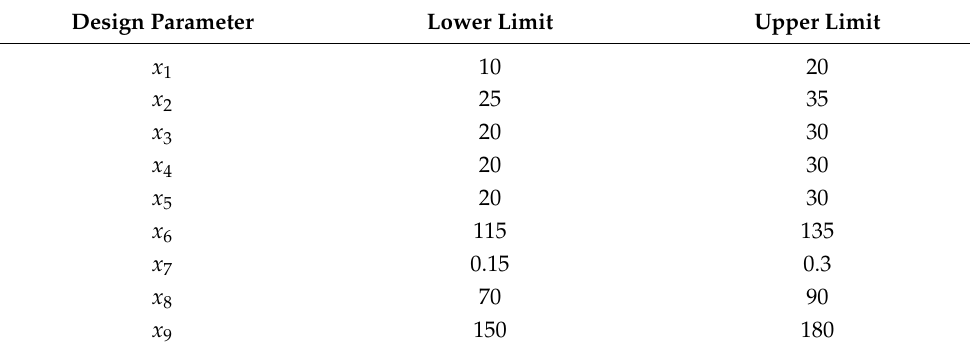
Table 4. Boundary range of design parameters.